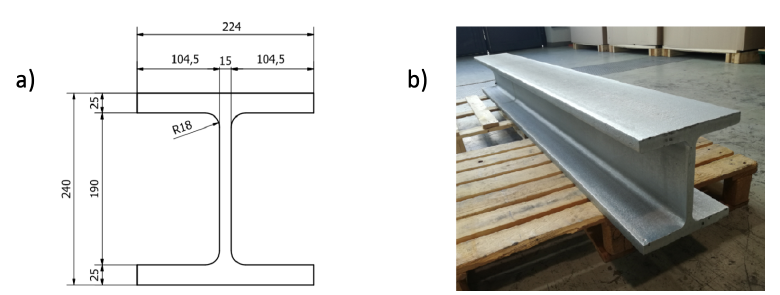
Figure 6. H-Shaped HEM220 beam: ( a ) sketch, ( b )